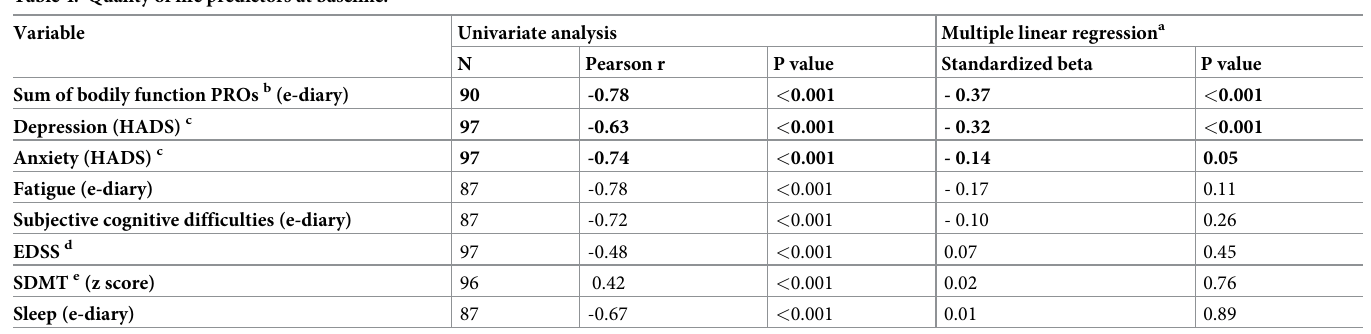
Table 4. Quality of life predictors at